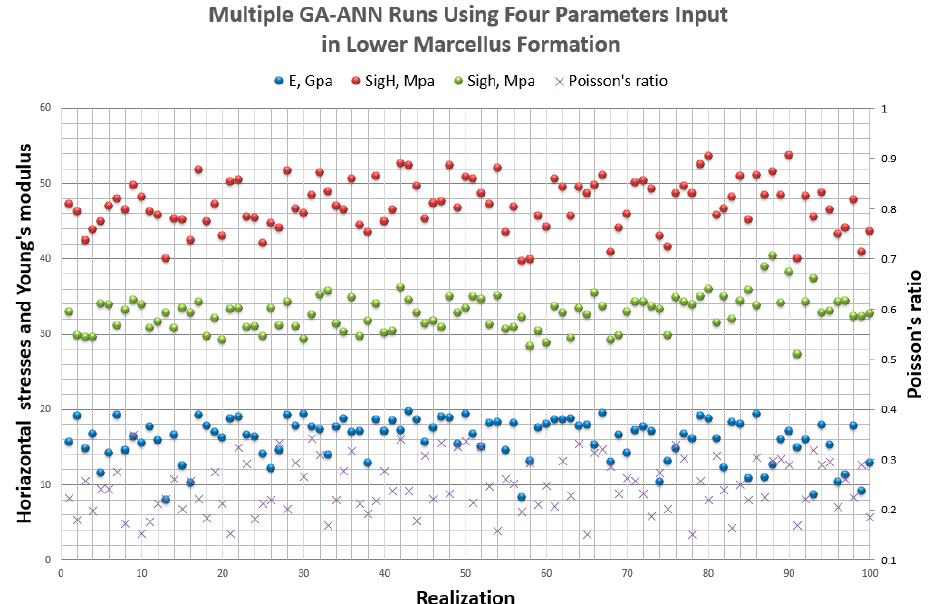
Figure 5. Results of Poisson’s ratio, Young’s modulus, Maximum horizontal stresses, and horizontal stresses of 100 ANN-GA realizations.